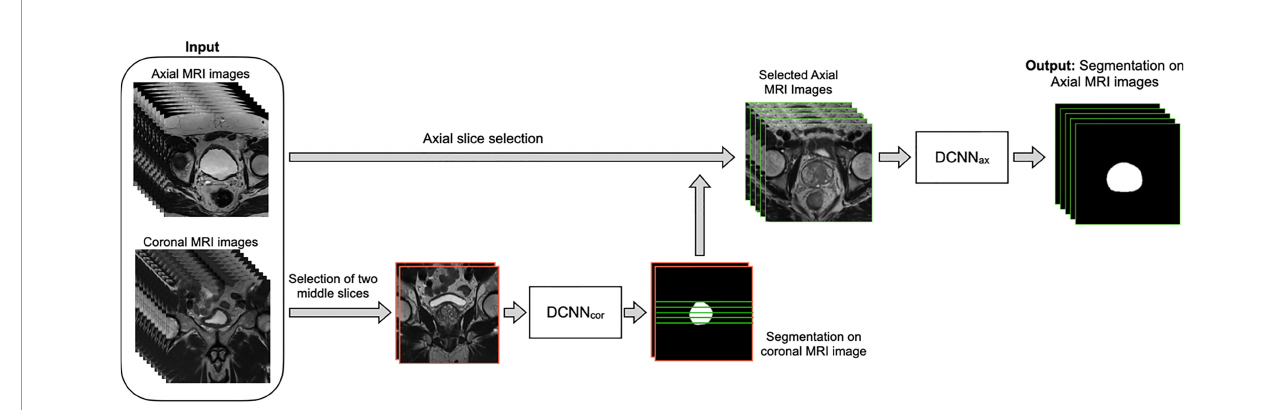
FIGURE 1 | The overall work fl ow of the automatic WPG segmentation with DANN. Both axial and coronal T2W images were used as input, where the coronal images were used to assist the selection of certain axial images containing the prostate gland. DANN cor was fi rstly performed on the two middle coronal images, indicated by images with the red border. Next, green lines selected by the prostate segmentation on the coronal images were used to determine the selection of axial slices (images with green borders). Once the axial images were selected, DANN ax was performed on the axial MRI slices for the segmentation of WPG.